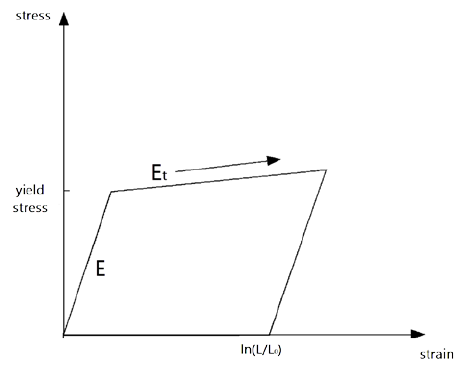
Figure 1. Elastoplastic bilinear material of MAT 3